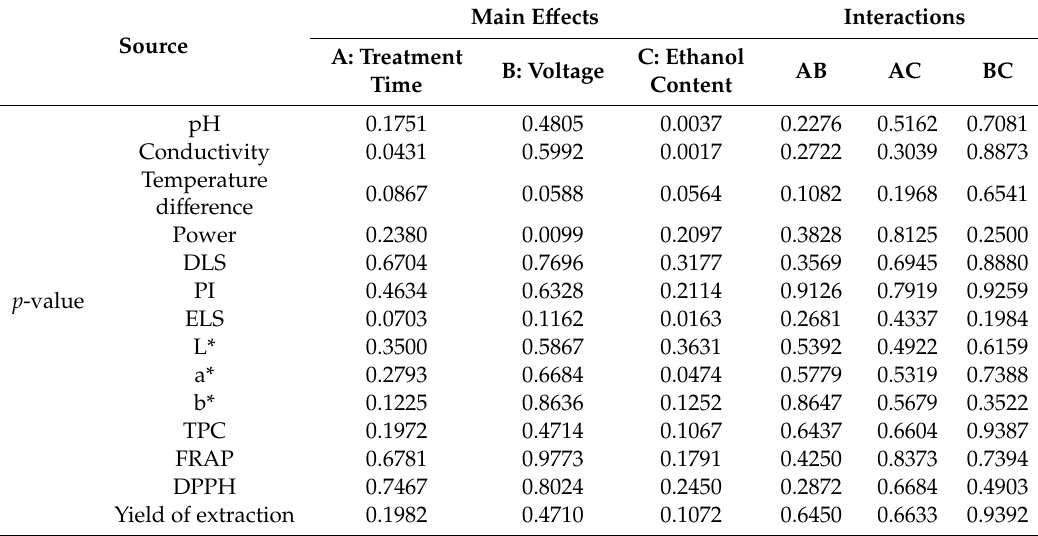
Table 7. Statistical significance for pH, conductivity, temperature di ff erence, power, dynamic light scattering (DLS), polydispersity index (PI), electrophoretic light scattering (ELS), L*, a*, b*, total phenolic table decomposes the variability of each parameter into contributions due to various factors for OLE treated with argon.